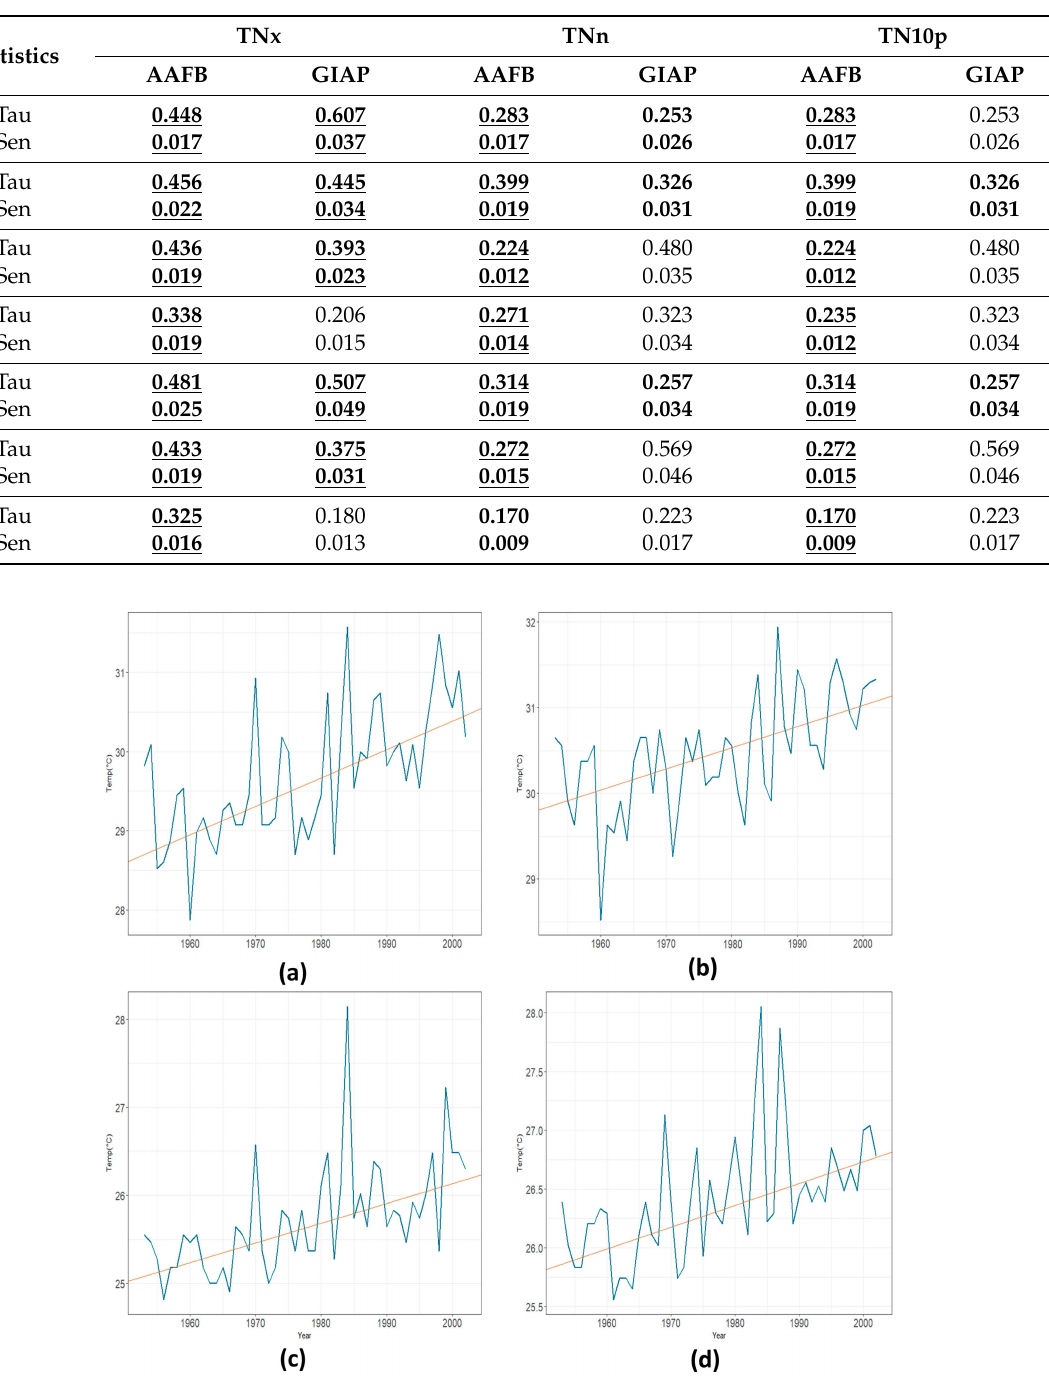
Figure 3. Trends in two-seasonal maximum of Tmax (TXx) and Tmin (TNx) over 1953–2002 at AAFB. ( a ) dry-season of TXx, ( b ) wet-season of TXx, ( c ) dry-season of TNx, and ( d ) wet-season of TNx. Red lines are Theil–Sen regression